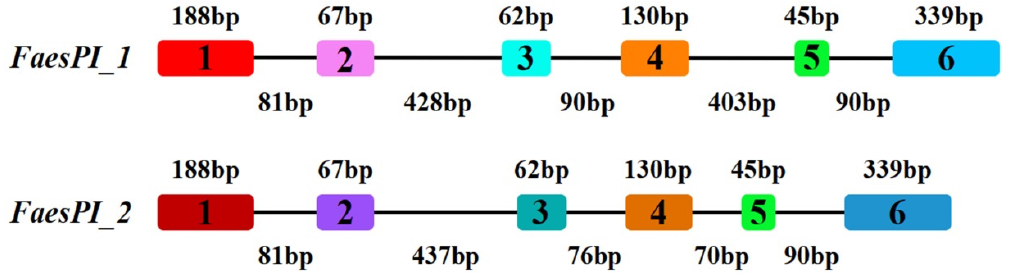
Figure 1. Exon-intron structures of FaesPI_1 and FaesPI_2 gene s. Color boxes present exons while black lines present introns.